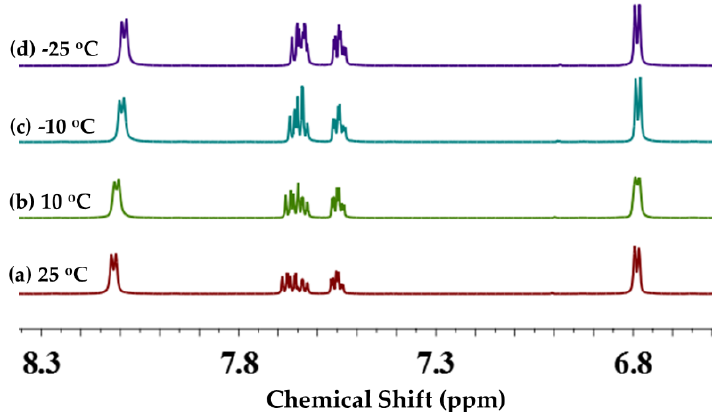
Figure 6. 1 H NMR spectra showing the changes observed for the substitution of triphenylphosphine oxide from cis -[NbO(ca) 2 (H 2 O)OPPh 3 ] − (0.03 M) by DMAP (0.013 M) at four different temperatures ◦ C) in CD (( a – d ); 25, 10, −1 0, and −2 5 °C) in CD 3 CN. (( a – d ); 25, 10, − 10, and − 25 3